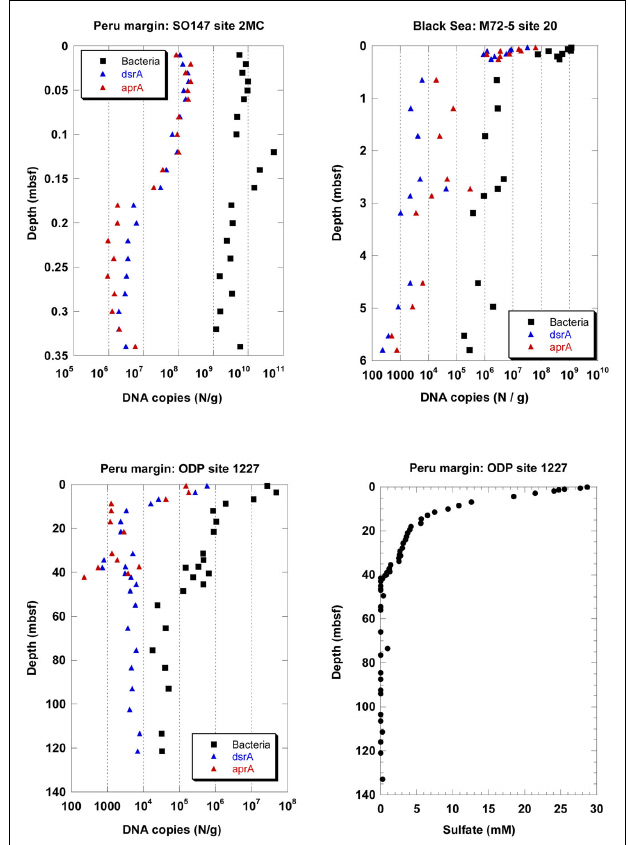
FIGURE 1 | Depth profiles of DNA copy numbers of the functional genes aprA and dsrA as marker for sulfate-reducing prokaryotes (SRP) and the 16S rRNA gene of total Bacteria at three sediment sites, surface (site 2MC, 0–0.35 mbsf) and deep (site 1227, 0–121.4 mbsf) sediments on the Peru margin, and in the Black Sea (site 20, 0–5.8 mbsf), and depth profile of pore water sulfate concentrations at site 1227 (0–135 mbsf, D’Hondt et al., 2004) on the Peru margin. (cid:2) , Bacteria ; (cid:3) , dsrA ; (cid:3) , aprA